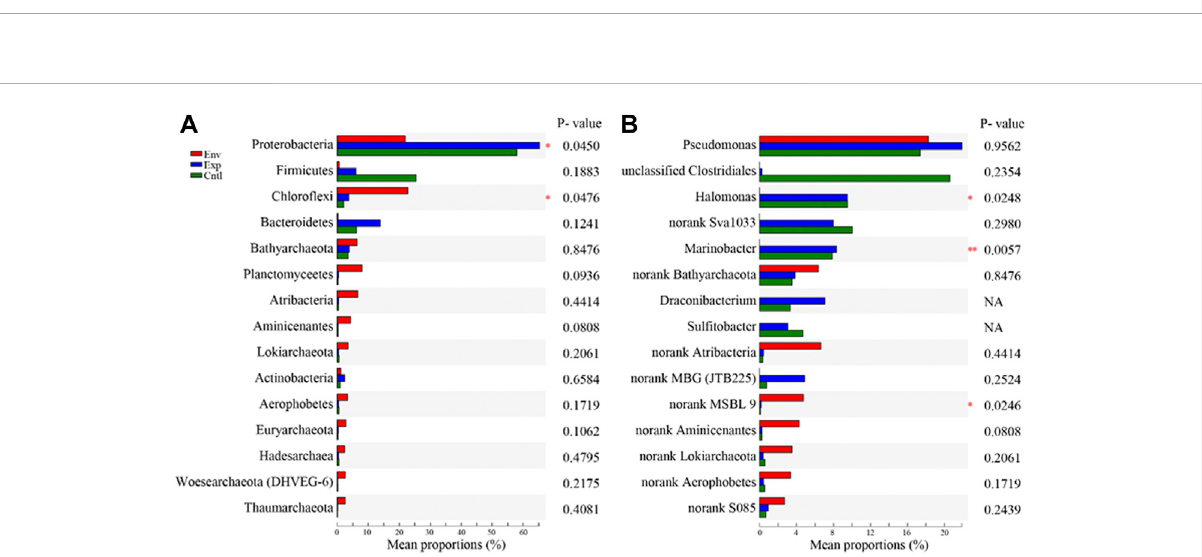
FIGURE 7 Statisticalcomparison of the relative abundances (A) at thephylum level and (B) atthe genus level among theenvironmental sedimentsamples (Env) and the related incubation slurries amended with 13 CH 4 (Exp)and N 2 (Cntl). One-way ANOVA was used to evaluate the signi fi cance of differences between the indicated groups. * p < 0.05 and ** p <